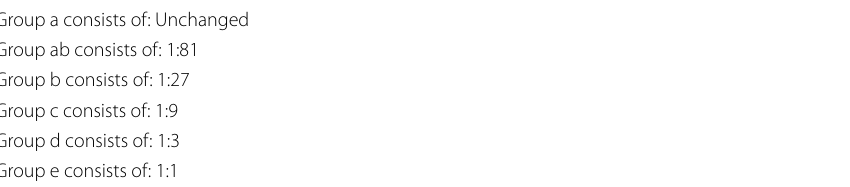
Table 29 HSD test groupings after ANOVA of AUPRC for the RUS